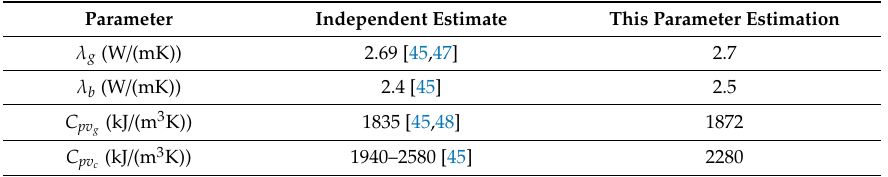
Table 3. Parameter estimation results.